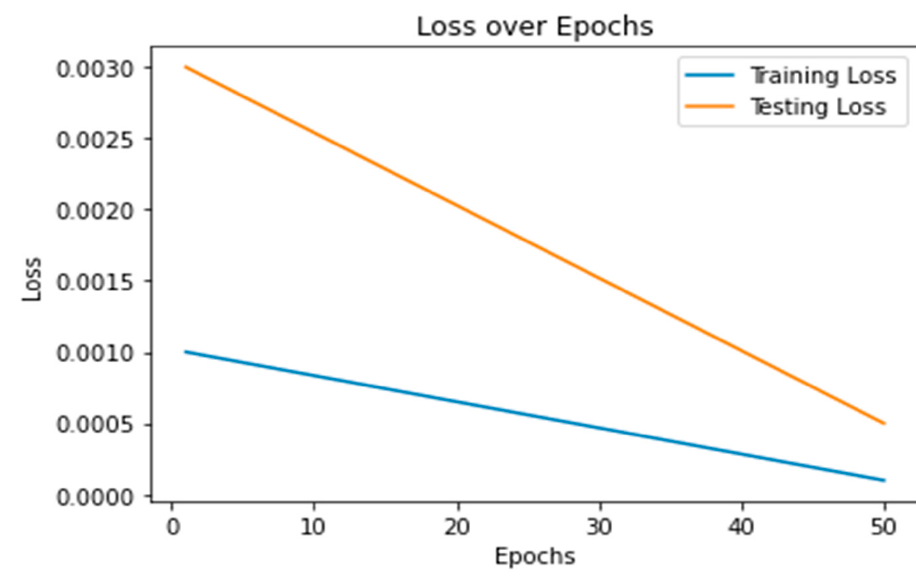
Figure 10. Model loss for fine-tuned 3D U-Net